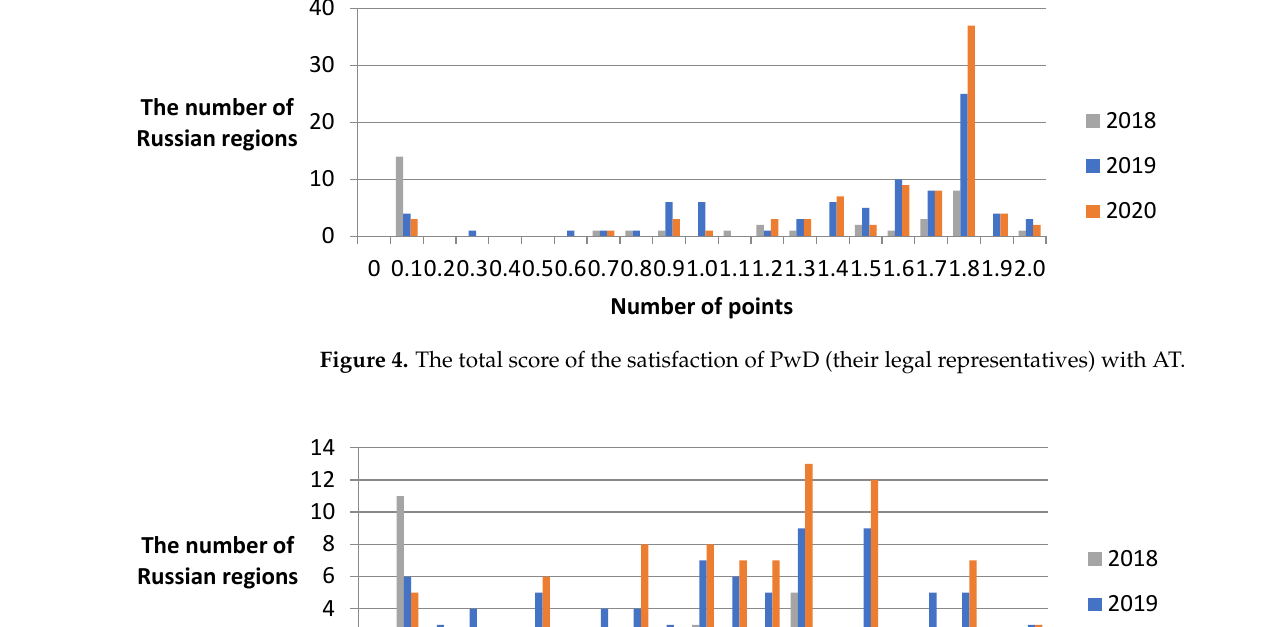
Figure 4. The total score of the satisfaction of PwD (their legal representatives) with AT.